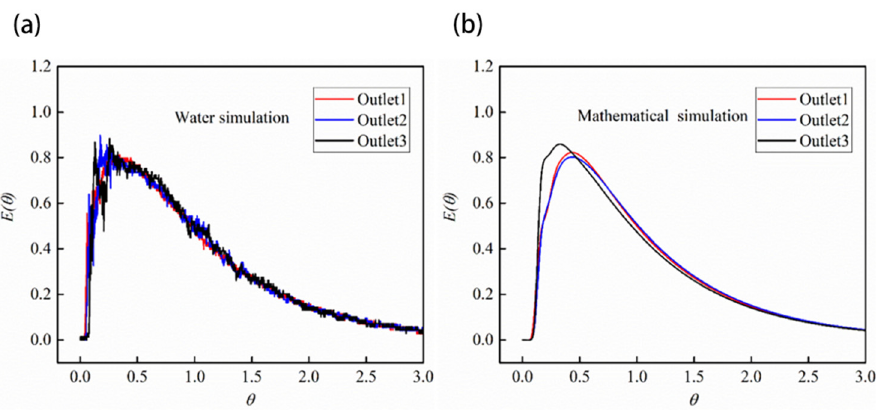
Figure 6. Comparison of RTD (residence time distribution) curves for case FK-A0: ( a ) hydrodynamic modeling experiment; ( b ) mathematical simulation.